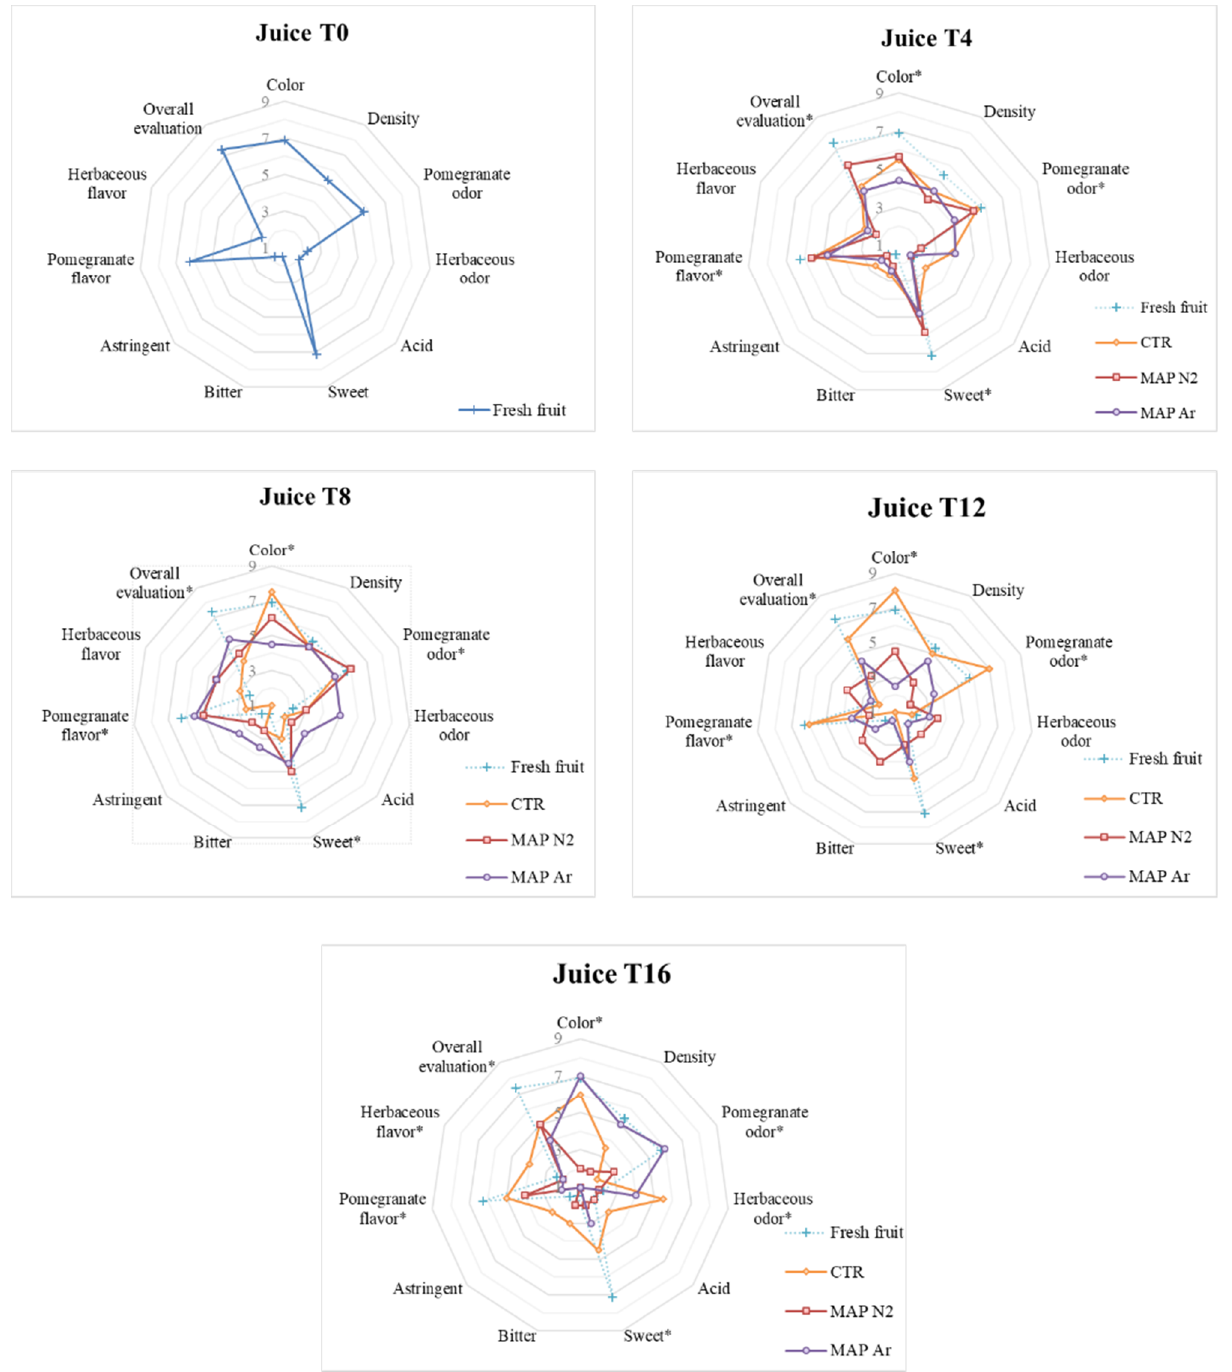
Figure 6. Sensory analysis performed on the juice arils treated with MAP (CTR: 20.9% O 2 + 0.04% CO 2 (passive-MAP); MAPN2: 10% O 2 + 5% CO 2 + 85% N2; MAPAr: 10% O 2 + 5% CO 2 + 85% Ar). Analyses were carried out after storage for 0 (T 0 ), 4 (T 4 ), 8 (T 8 ), 12 (T 12 ), and 16 (T 16 ) days at 4 ± 1 °C and 90 ± 5% RH. Scores of the fresh fruit, marked with +, are shown at all evaluation times for reference purpose. * indicates the presence of significant differences between treatments at the same analysis time.